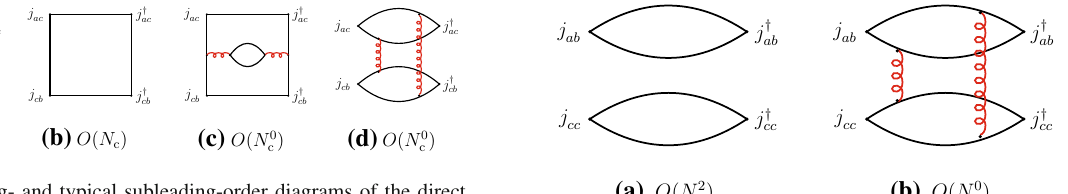
Fig. 8 Leading- and typical subleading-order diagrams of the direct channel I of Eq. (3.1)